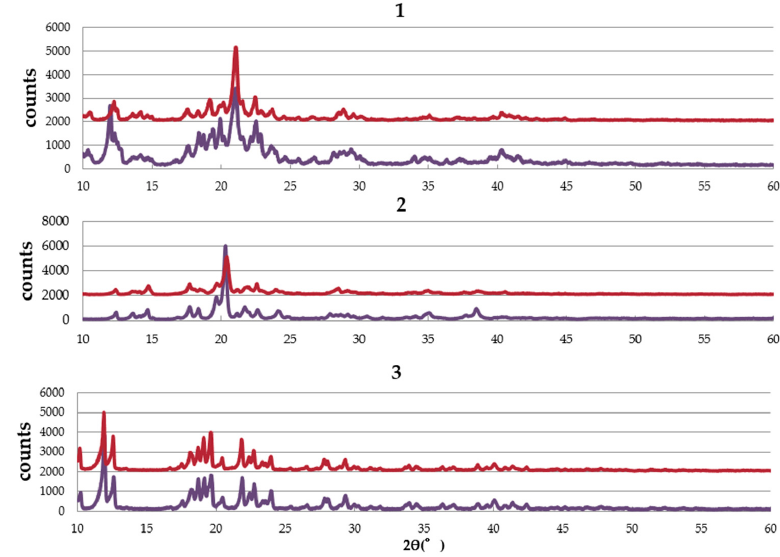
Figure 4. The powder X-ray diffraction (PXRD) patterns of 1 , 2 , and 3 . Red and purple show